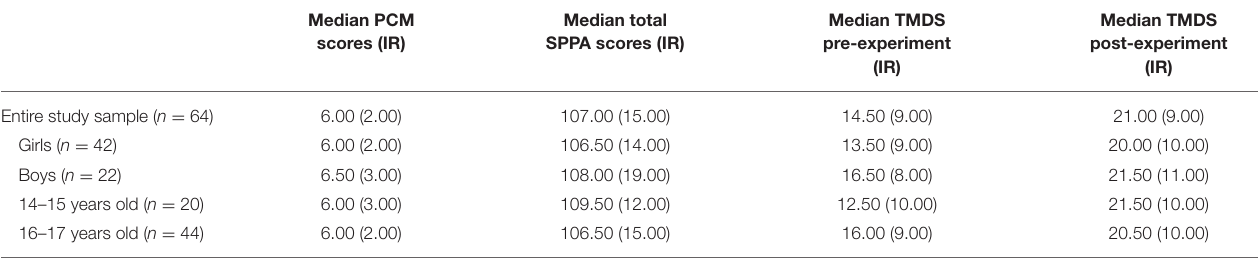
TABLE 2 | Median PCM and total SPPA scores; pre-experiment TMDS and post-experiment TMDS, as well as interquartile ranges (IR) between brackets.